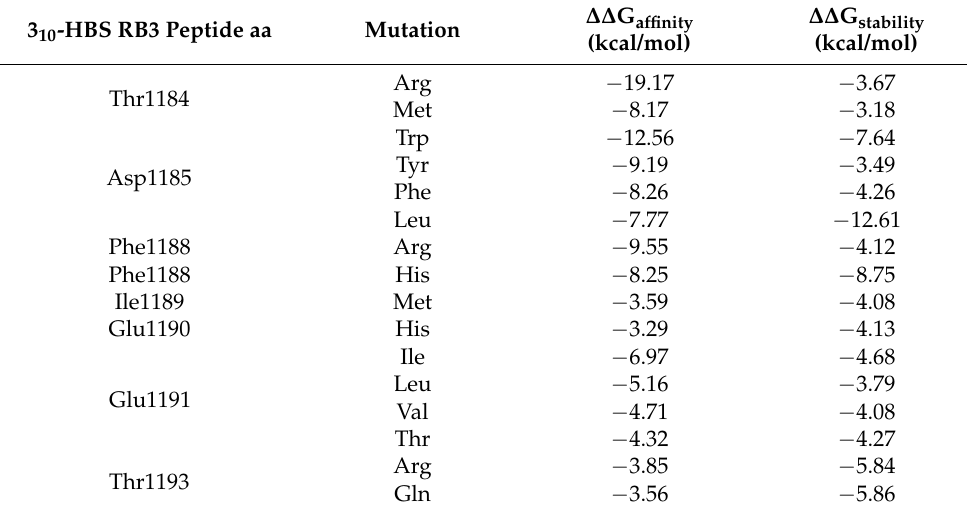
Table 5. Computational residue scanning results for the peptide 3 10 -HBS RB3, highlighting 16 promising